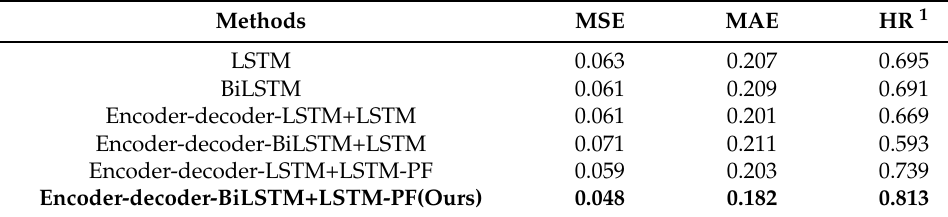
Table 3. Evaluation of method predictions effect.